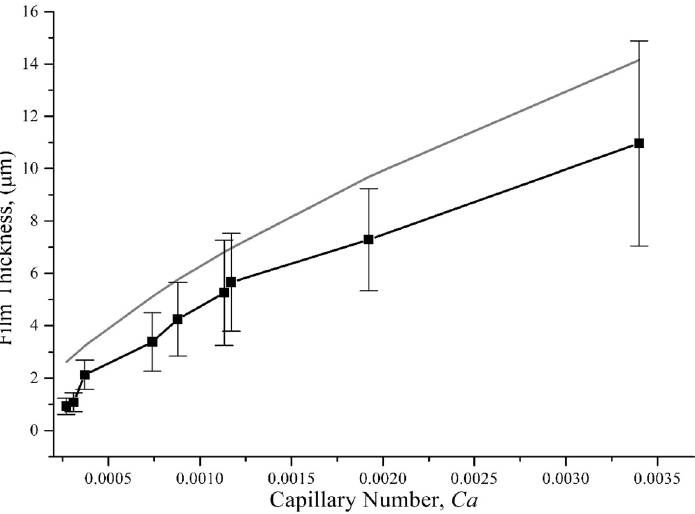
Figure 4. Polymer film thickness as a function of capillary number. The grey line corresponds to the expected (theoretical) liquid thickness. The solid rectangular points represent the experimentally measured film thickness with standard error shown for each data